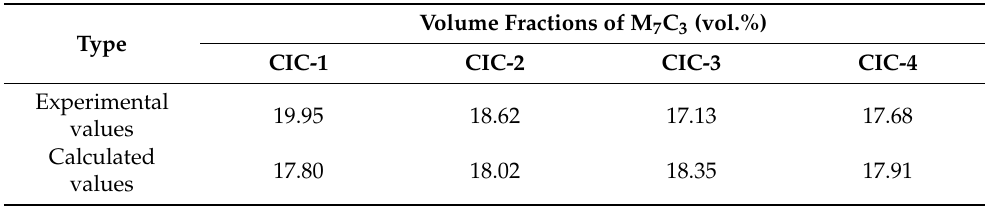
Table 2. Experimental and calculated volume fractions of M 7 C 3